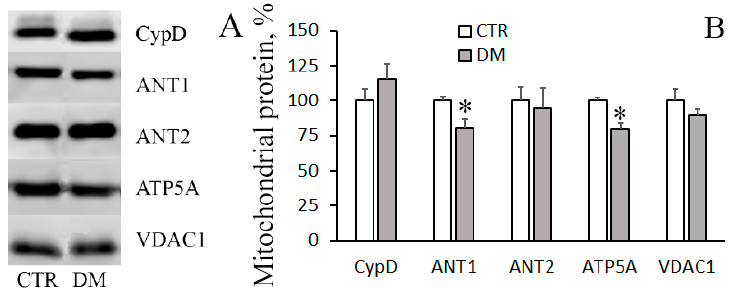
Figure 4. The levels of MPT-related proteins in the liver mitochondria of CTR and DM rats. ( A ) Western blot analysis of MPT-related proteins: CypD, ANT1, ANT2, and ATP5A. ( B ) Summarized data on the levels of these proteins in mitochondria. VDAC1 was used as a marker. Values are given as means ± SEM ( n = 4). * p < 0.05 compared to controls.